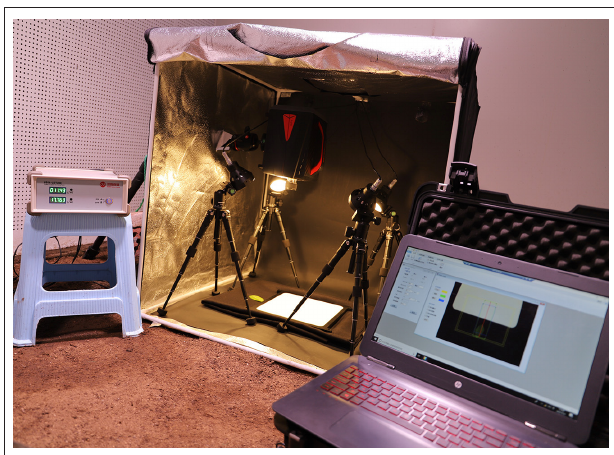
FIGURE 1 | Hyperspectral image acquisition system.